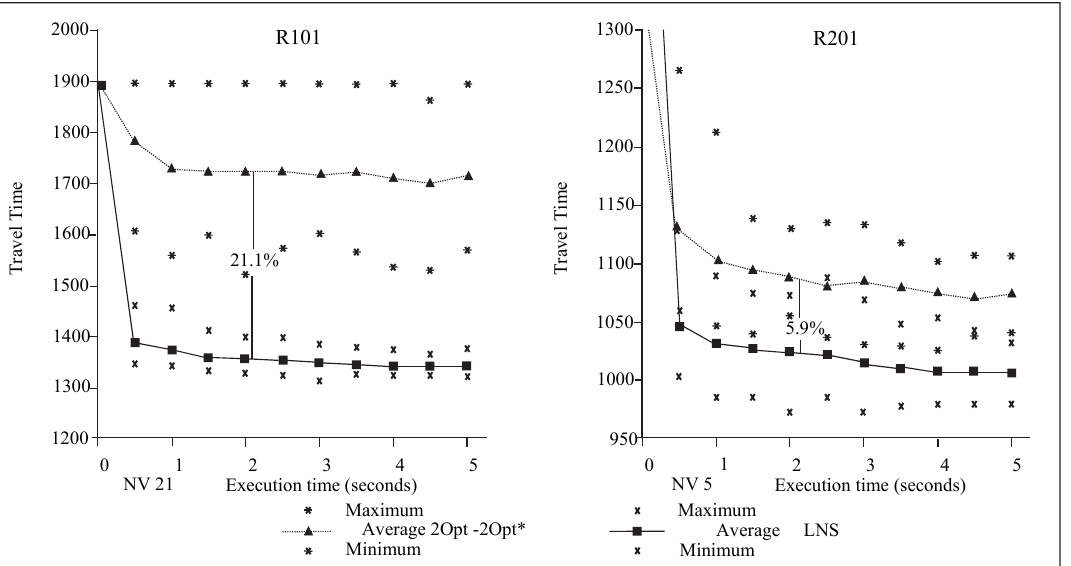
Fig. 5 . Behaviour of LNS movements vs. 2-opt and 2-opt* in the presence of time-dependent travel times. Solomon instances R101 and R102 (100 customers) – Figliozzi (2012) speed case